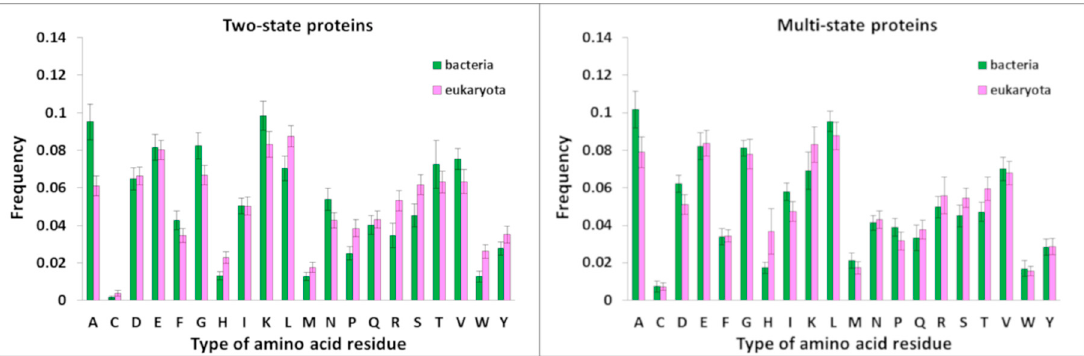
Figure 5. Amino acid composition of the bacterial and eukaryotic proteins with two- and multi-state kinetics.